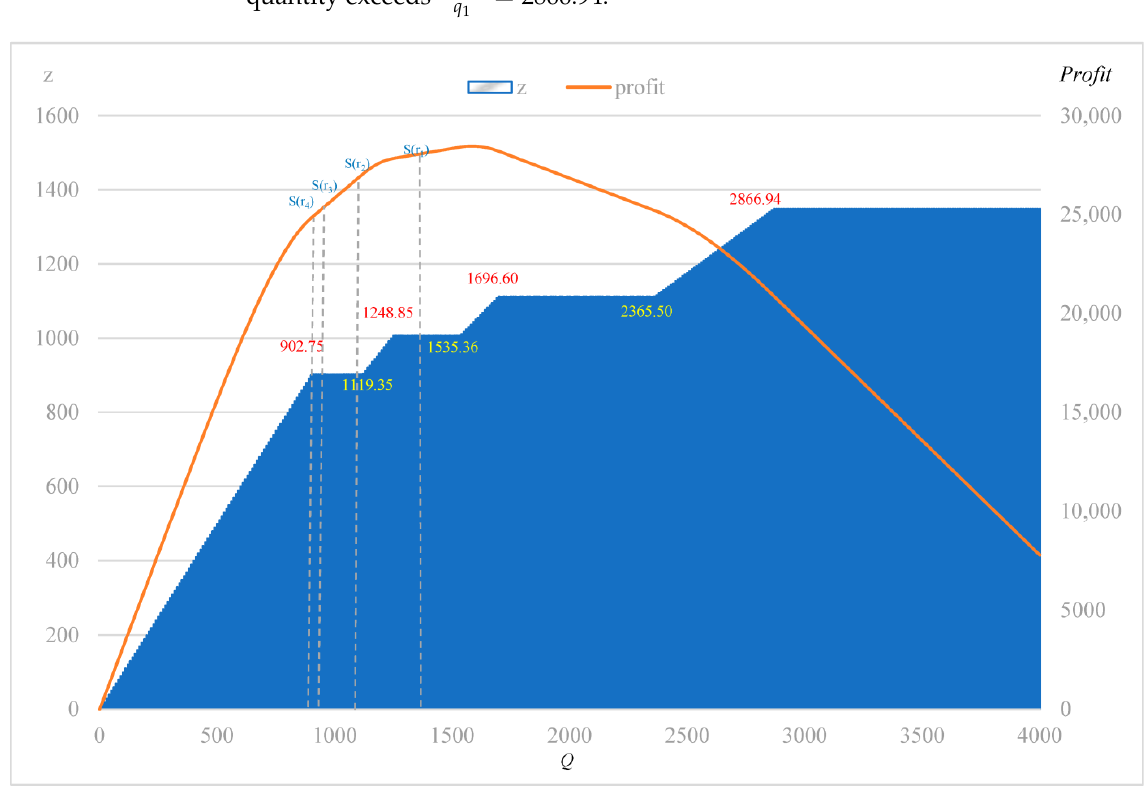
Figure 2. The optimal production quantity